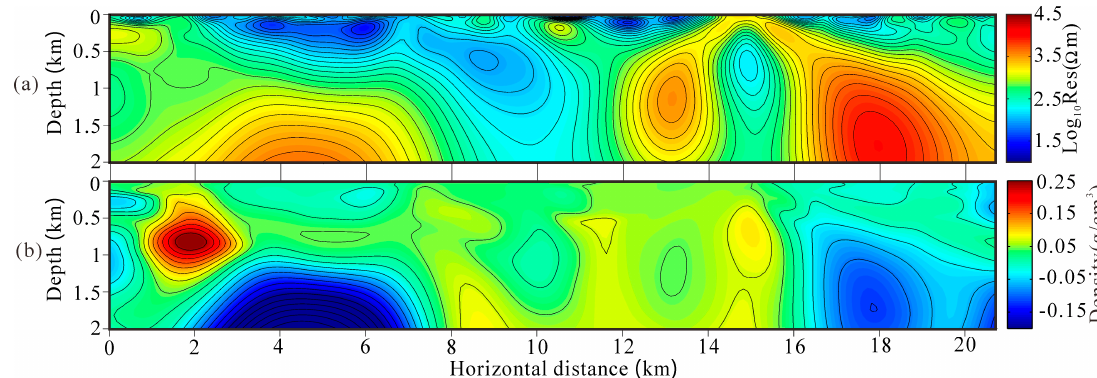
Figure 14. The results of joint inversion using smooth regularization: resistivity model ( a ), residual density model ( b ).